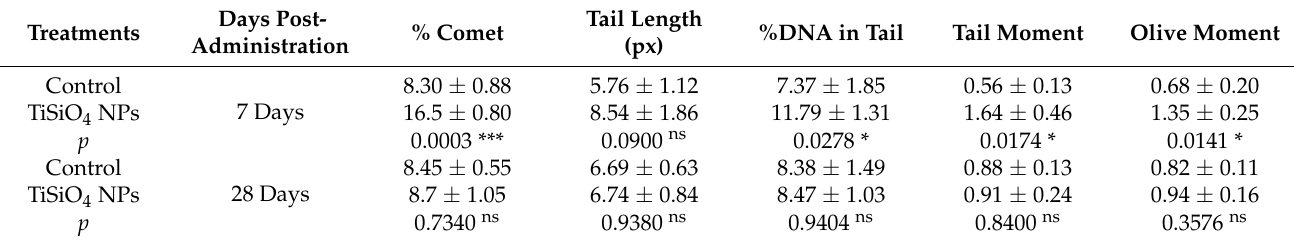
Table 5. Comet assay indices in liver male rats exposed orally to 250 mg ≤ 50 nm TiSiO 4 NPs/kg